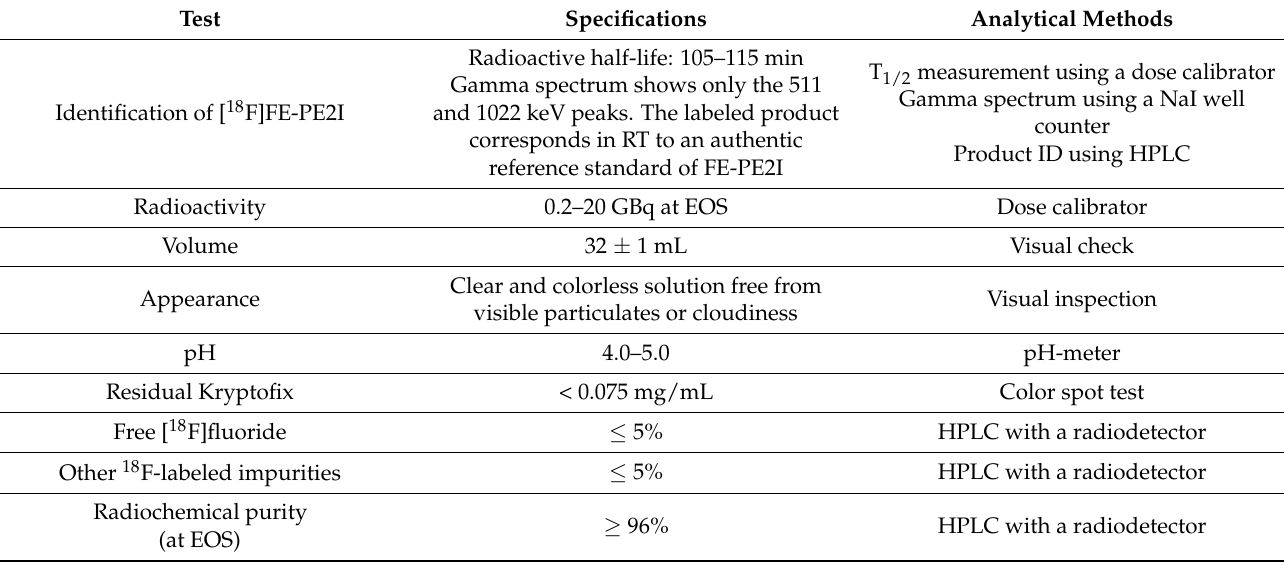
Table 6. Specifications and analytical methods for the quality control of [ 18